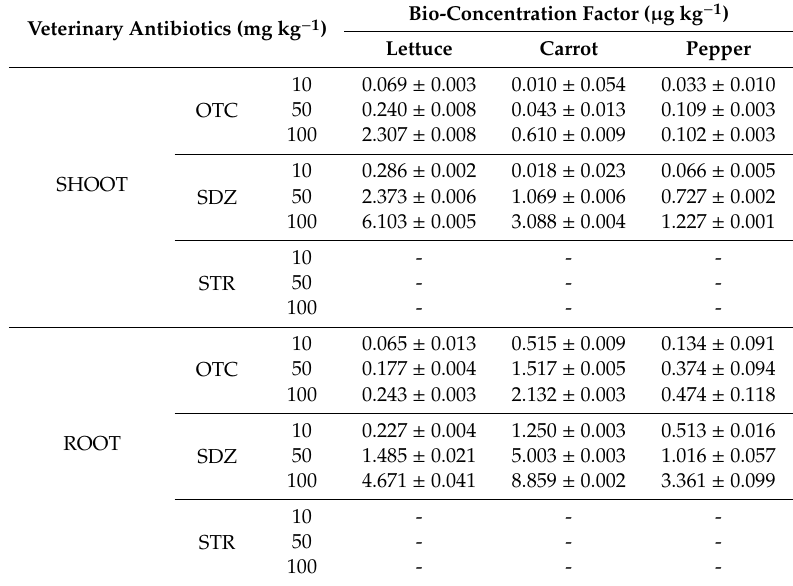
Table 4. Concentration of veterinary antibiotics extracted from the soil planted with lettuce, carrot, and pepper plants at the end of the experimental